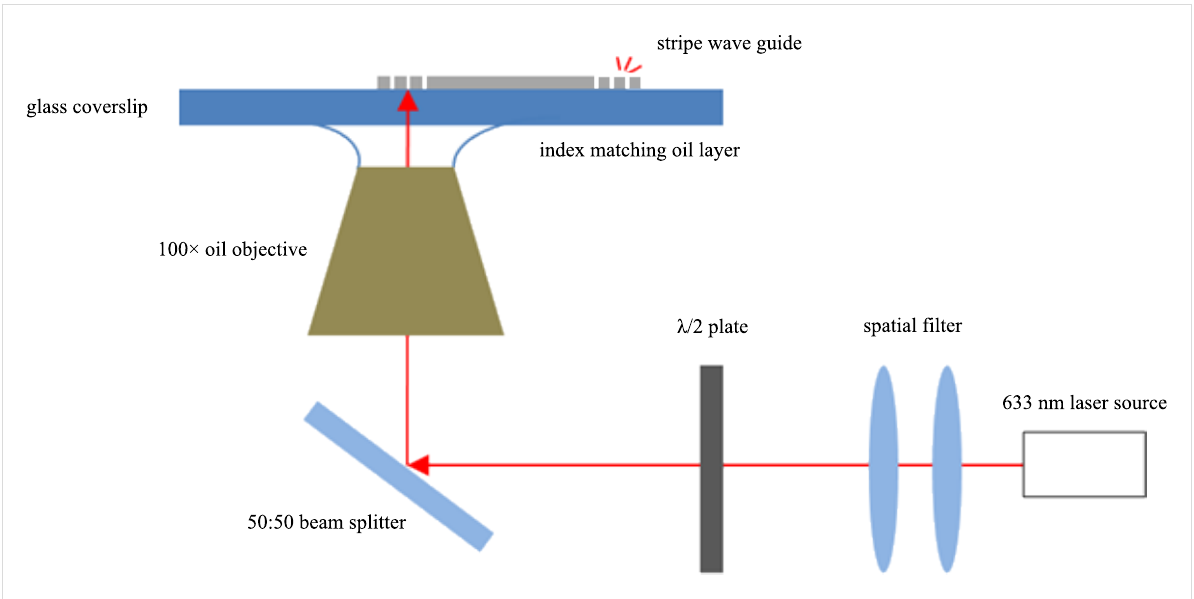
symmetric emission band with a maximum at 655 nm and are about 10 nm in size. Above QDs were diluted 50× in deionised water and spin coated onto the SiO 2 surface. Under these condi- tions the QD layer is highly dense. A schematic diagram of the sample cross-section is depicted in Figure 4 (image is not to